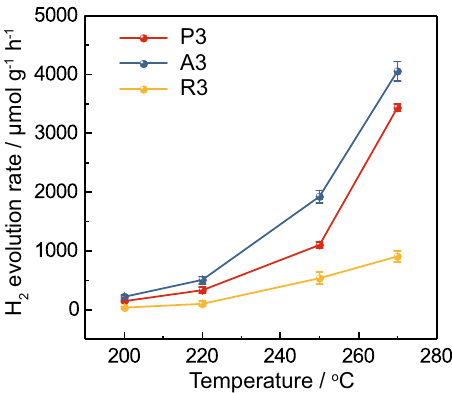
Fig. 9 Photocatalytic water splitting activity study of the N-doped TiO 2 samples. Photocatalytic water-splitting activities over P3, A3 and R3 photocatalysts at different temperatures under visible-light illumination (red: P25; blue: anatase; yellow: rutile). Error bars indicate the standard